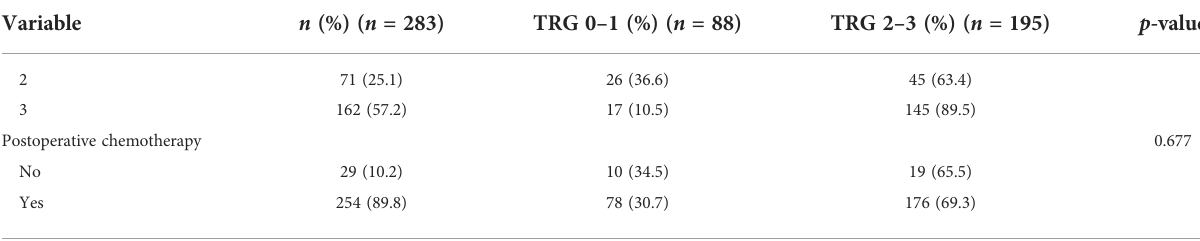
and prognosis The relations between NLR, PLR, and prognosis were analyzed according to clinicopathological factors, as shown in Table 5. In female patients, low NLR patients had signi fi cantly